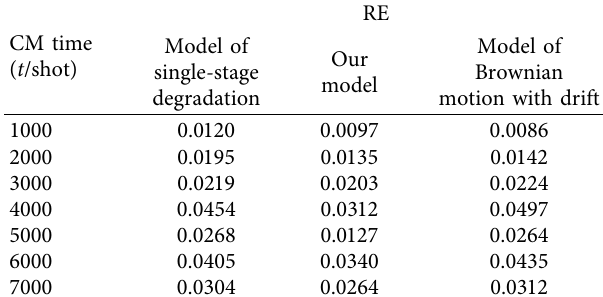
Table 6: RE of RUL prediction for No. 9